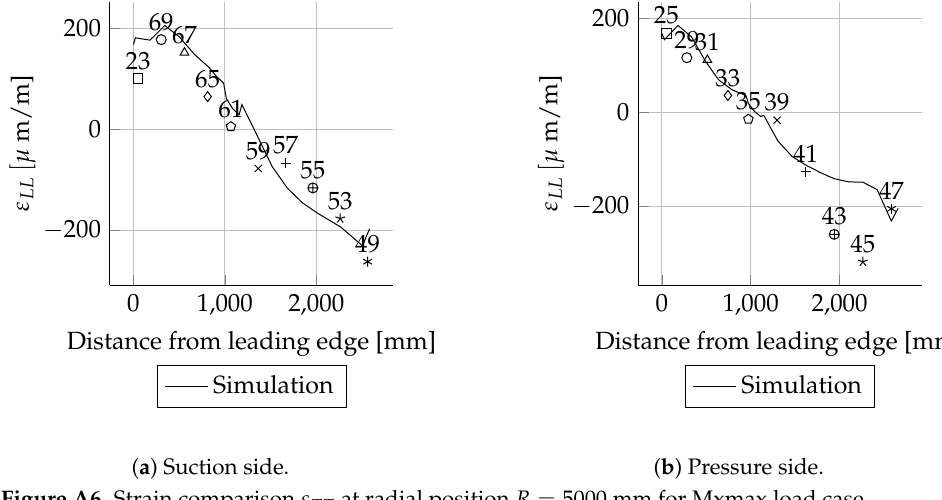
Figure A6. Strain comparison ε TT at radial position R = 5000 mm for Mxmax load case.